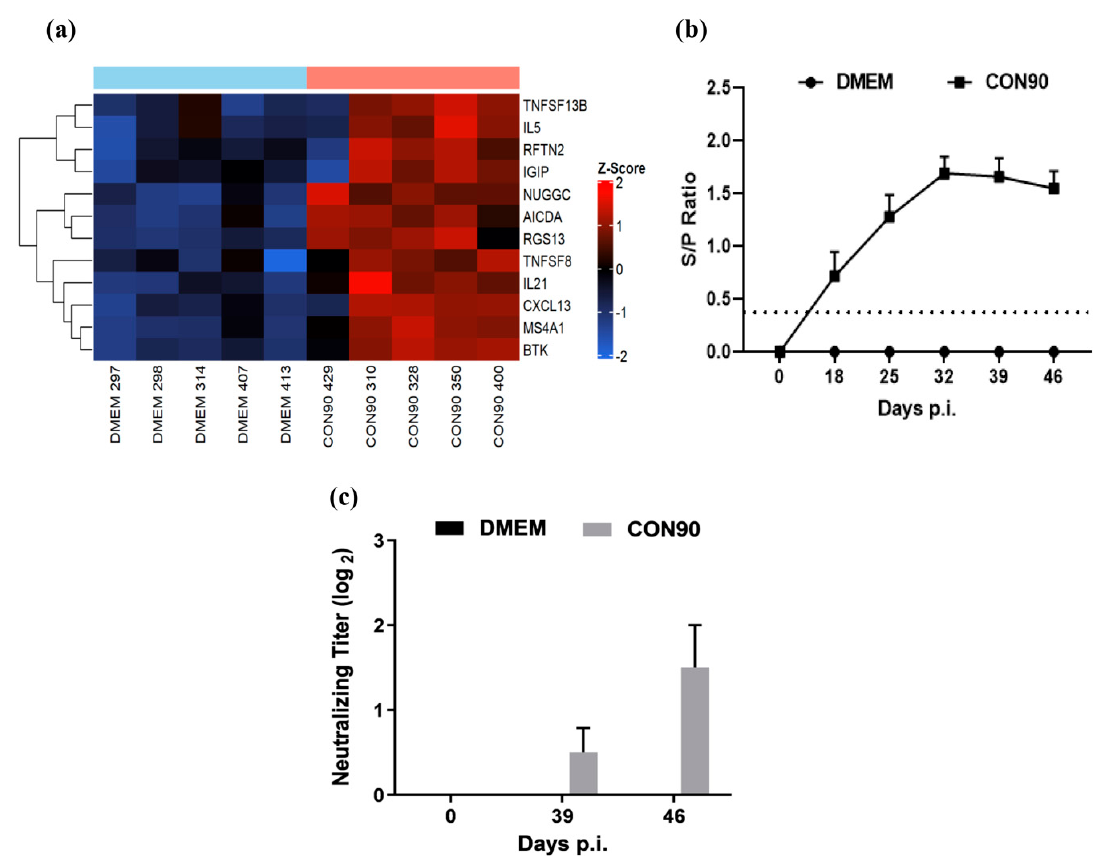
Figure 8. Humoral immune response. ( a ) Heat map of differentially expressed genes associated with the humoral immune development. The heatmap was generated in the same manner as described in the legend to Figure 4. ( b ) PRRSV-specific antibodies were detected in the serum using IDEXX PRRS X3 Antibody test (IDEXX Laboratories, lnc., Westbrook, ME, USA). The horizontal dotted line indicates the cutoff (S/P value, 0.4) of the assay. ( c ) Serum virus neutralizing antibodies measured against CON90 at 39 and 46 days post infection. Dataset represents mean ± S.E.M values calculated from five pigs in each treatment group.